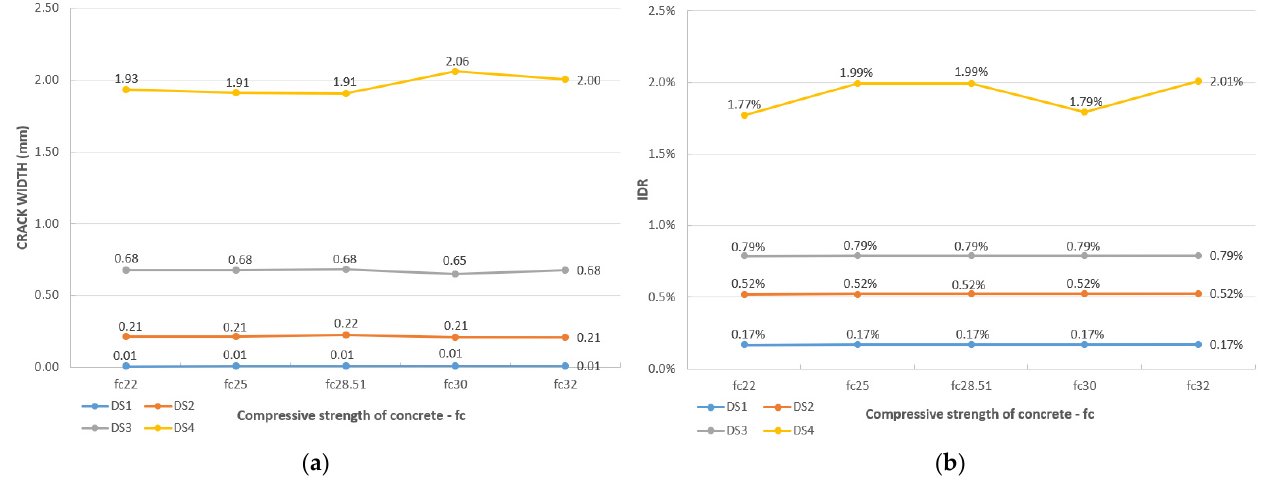
Figure 12. Correlation of damage states (DS) with compressive strength of concrete ( fc ) associated with: ( a ) crack width (mm); ( b ) IDR (%).